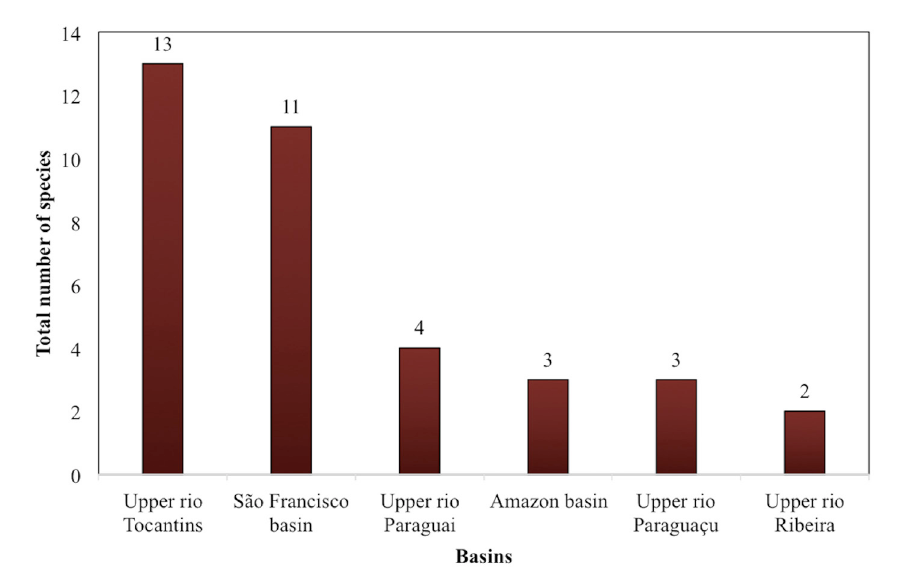
FIGURE 2 | Distribution of Brazilian subterranean fish species according to basin.